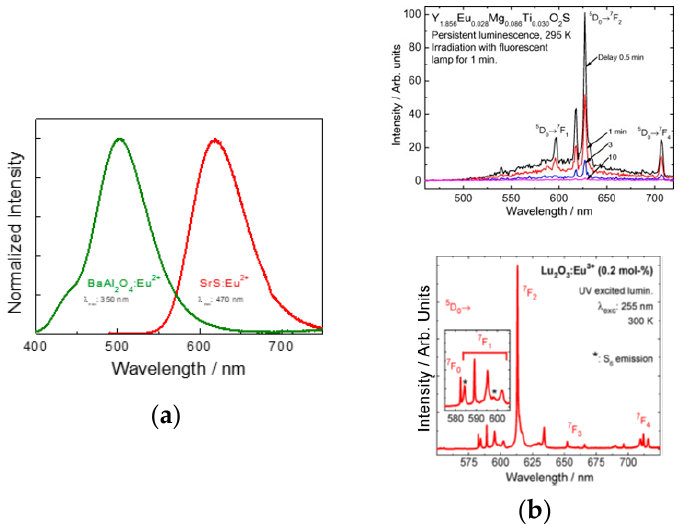
Figure 9. Emission spectra for ( a ) Eu 2+ in two different hosts BaAl 2 O 4 (left, green line) and SrS (right, red line) and ( b ) Eu 3+ doped Y 2 O 2 S (top) [150] and Lu 2 O 3 materials (bottom) [171]. Reproduced from [150] with permission from Elsevier. Reprinted with permission from [171]. Copyright (2016) American Chemical Society.